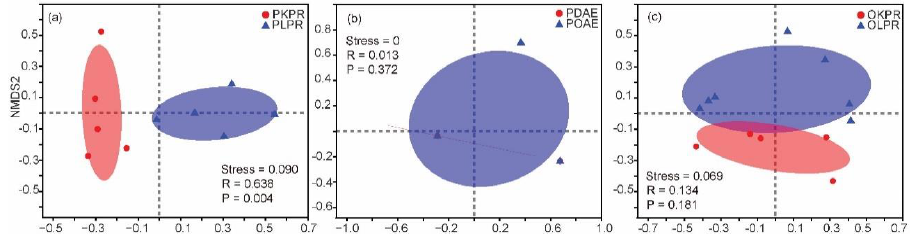
Figure 5. Comparison of gut bacterial microbiota for populations of peach fruit moth (PFM) Carposina sasakii and the oriental fruit moth (OFM) Grapholita molesta on pear ( a ), apple ( b ) and peach shoot ( c ). Due to the limited number of samples on peach shoot, the above beta diversity cannot be conducted for populations of OFM collected from two orchards of peach